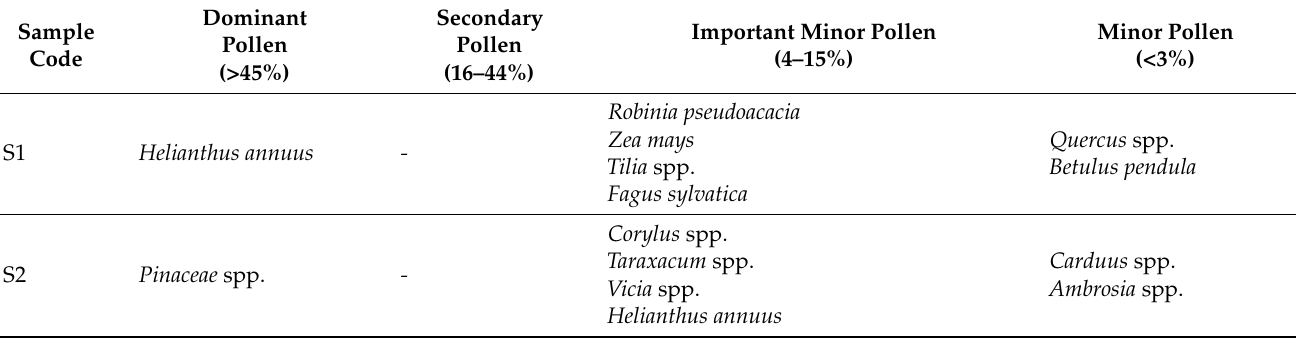
Table 1. Palynological analysis: Plant species giving the predominant, secondary, important minor and minor pollen in the analyzed bee